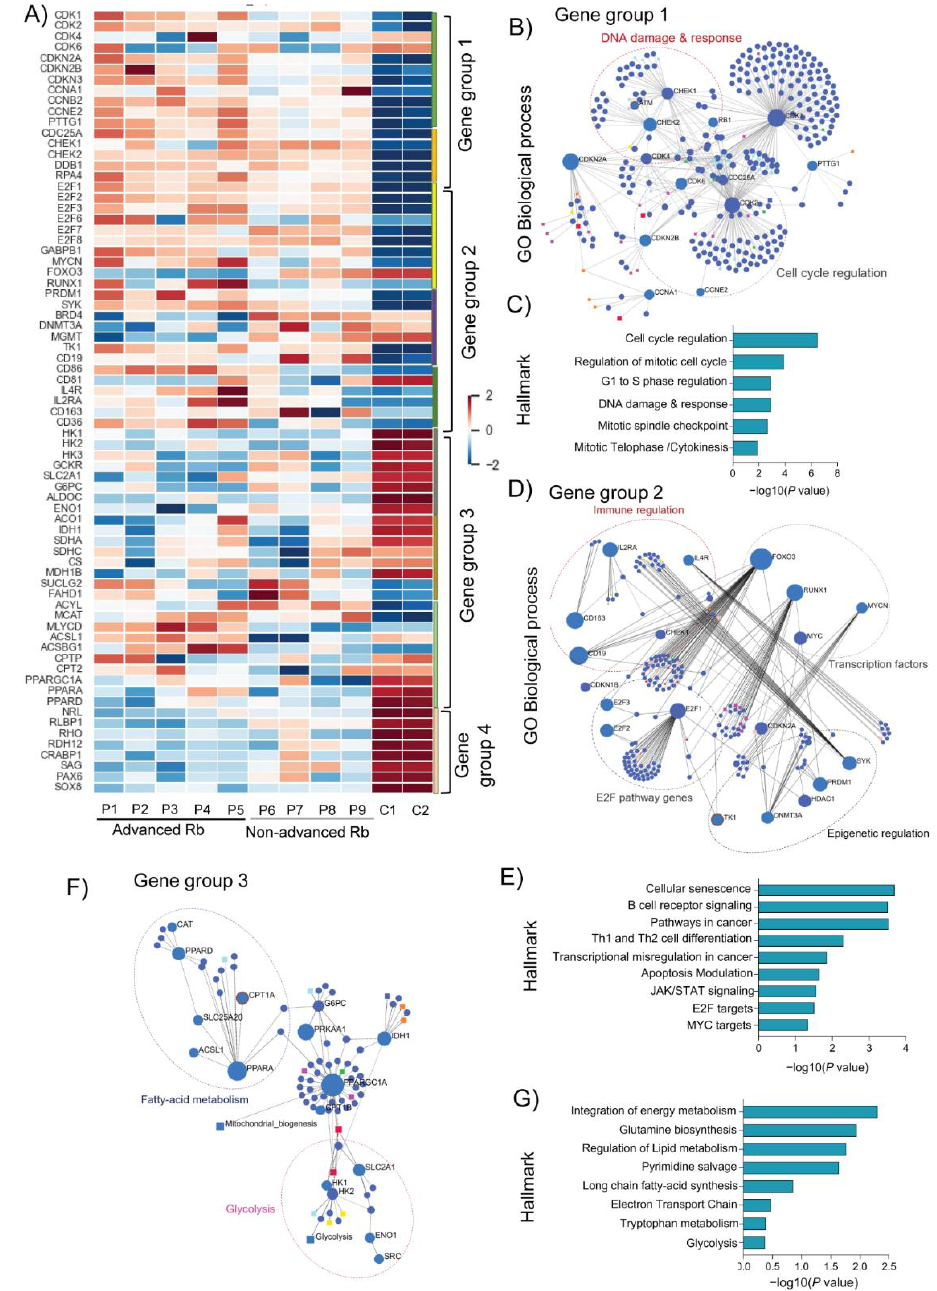
Figure 2. Distinct genes and biological processes are altered in advanced and non-advanced retinoblastoma. ( A ) Heatmap showing significantly differentially expressed genes identified four main gene groups in advanced ( n = 5) and non-advanced Rb ( n = 4), compared to pediatric retina controls ( n = 2). Genes were grouped based on the pathways reported in GOBP. Results are represented as a network of enriched genes sets (nodes) connected to their overlapping pathways (edges). The node size is proportional to the total number of genes in the gene set of interest. ( B ) Gene group 1 represents an enriched cluster of genes in the cell cycle, and the DNA damage and response pathway. ( C ) List of functional pathways regulated by the gene sets in Group 1. ( D ) Gene group 2 represents an enriched group of genes belonging to transcriptional regulation, immune system regulation, and epigenetic factors. ( E ) List of functional pathways regulated by the gene sets in group 2. ( F ) Gene group 3 represents an enriched set of genes belonging to cellular metabolic processes such as glycoly- sis, Krebs cycle, and fatty acid metabolism. ( G ) List of functional pathways regulated by the gene sets in group